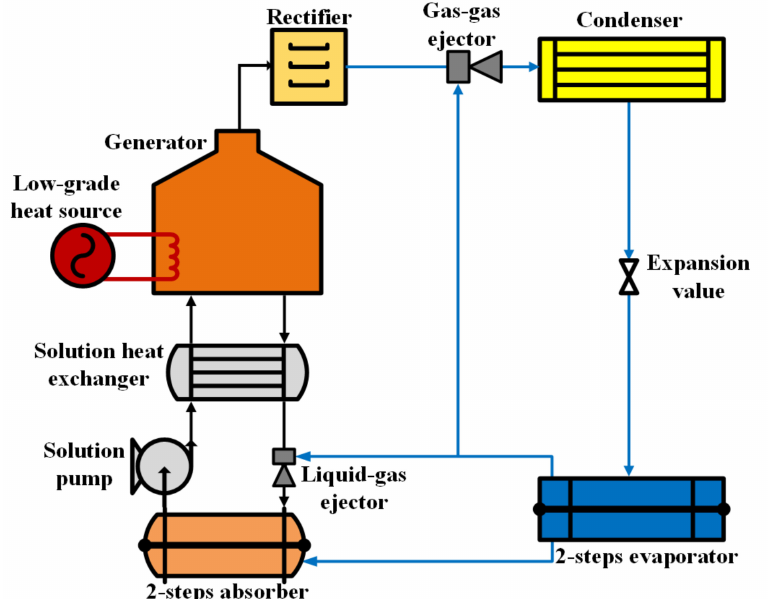
Figure 20. Proposed dual-ejector absorption refrigeration system (DEARS) with two-step evaporation– absorption